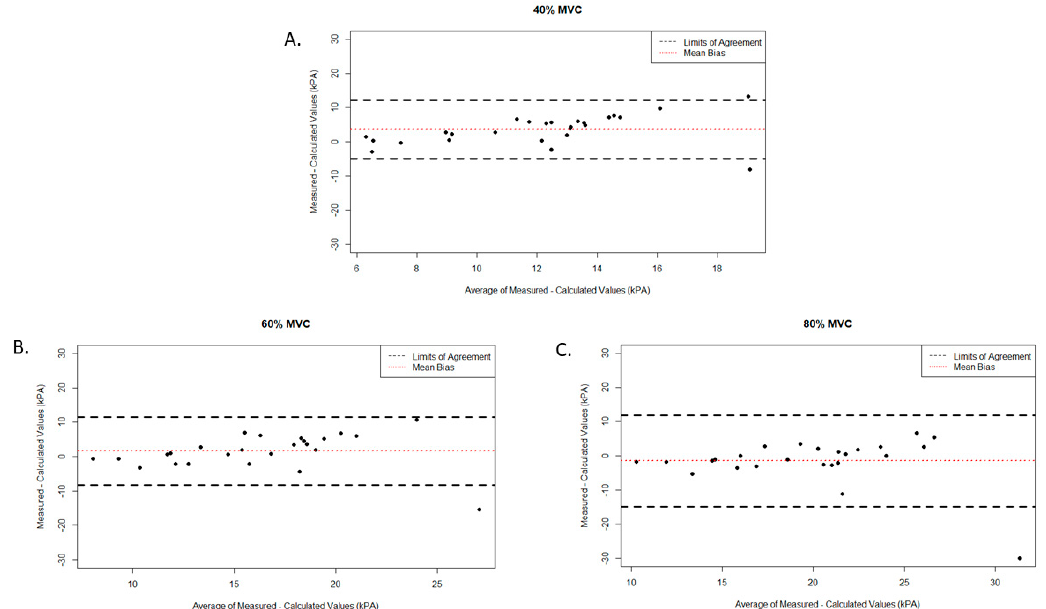
Figure 3. Bland–Altman plots of lip intensity estimates. MVC = maximal voluntary isometric contraction. ( A ). 40% MVC; ( B ). 60% MVC; ( C ). 80% MVC.